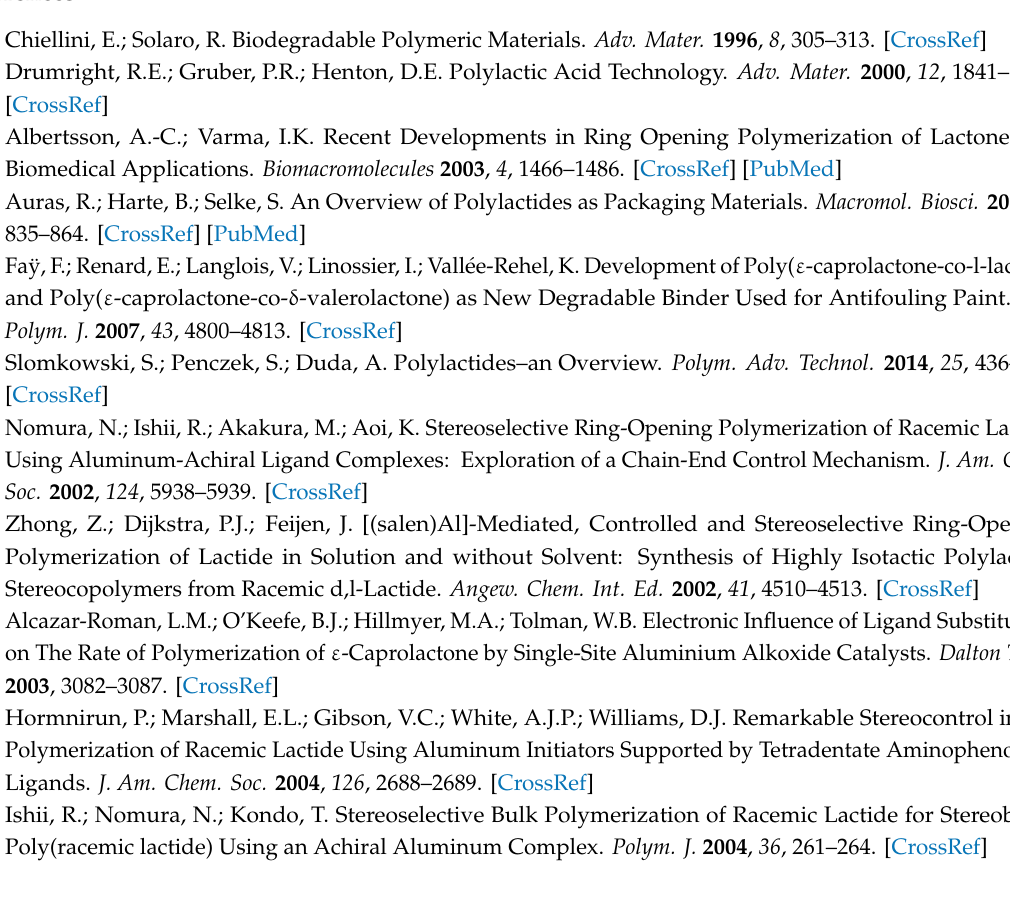
Supplementary Materials: The optimized structures involved in this study are available online at http: // www. mdpi.com / 2073-4360 / 11 / 9 / 1530 / s1, Table S1: Cartesian coordinate of Ceq1a, Table S2: Cartesian coordinate of CeqTS1a, Table S3: Cartesian coordinate of Ceq2a, Table S4: Cartesian coordinate of Ceq3a, Table S5: Cartesian coordinate of CeqTS2a, Table S6: Cartesian coordinate of Ceq4a, Table S7: Cartesian coordinate of Cax1a, Table S8: Cartesian coordinate of CaxTS1a, Table S9: Cartesian coordinate of Cax2a, Table S10: Cartesian coordinate of Cax3a, Table S11: Cartesian coordinate of CaxTS2a, Table S12: Cartesian coordinate of Cax4a, Table S13: Cartesian coordinate of Ceq1b, Table S14: Cartesian coordinate of CeqTS1b, Table S15: Cartesian coordinate of Ceq2b, Table S16: Cartesian coordinate of Ceq3b, Table S17: Cartesian coordinate of CeqTS2b, Table S18: Cartesian coordinate of Ceq5b, Table S19: Cartesian coordinate of Cax1b, Table S20: Cartesian coordinate of CaxTS1b, Table S21: Cartesian coordinate of Cax2b, Table S22: Cartesian coordinate of Cax3b, Table S23: Cartesian coordinate of CaxTS2b, Table S24: Cartesian coordinate of Cax4b, Table S25: Cartesian coordinate of Ceq1c, Table S26: Cartesian coordinate of CeqTS1c, Table S27: Cartesian coordinate of Ceq2c, Table S28: Cartesian coordinate of Ceq3c, Table S29: Cartesian coordinate of CeqTS2c, Table S30: Cartesian coordinate of Ceq4c, Table S31: Cartesian coordinate of Cax1c, Table S32: Cartesian coordinate of CaxTS1c, Table S33: Cartesian coordinate of Cax2c, Table S34: Cartesian coordinate of Cax3c, Table S35: Cartesian coordinate of CaxTS2c, Table S36: Cartesian coordinate of Cax4c, Table S37: Cartesian coordinate of Lax1a, Table S38: Cartesian coordinate of LaxTS1a, Table S39: Cartesian coordinate of Lax2a, Table S40: Cartesian coordinate of Lax3a, Table S41: Cartesian coordinate of LaxTS2a, Table S42: Cartesian coordinate of Lax4a, Table S43: Cartesian coordinate of Lax5a, Table S44: Cartesian coordinate of Lax1b, Table S45: Cartesian coordinate of LaxTS1b, Table S46: Cartesian coordinate of Lax2b, Table S47: Cartesian coordinate of Lax3b, Table S48: Cartesian coordinate of LaxTS2b, Table S49: Cartesian coordinate of Lax4b, Table S50: Cartesian coordinate of Lax5a, Table S51: Cartesian coordinate of Lax1c, Table S52: Cartesian coordinate of LaxTS1c, Table S53: Cartesian coordinate of Lax2c, Table S54: Cartesian coordinate of Lax3c, Table S55: Cartesian coordinate of LaxTS2c, Table S56: Cartesian coordinate of Lax4c, Table S57: Cartesian coordinate of